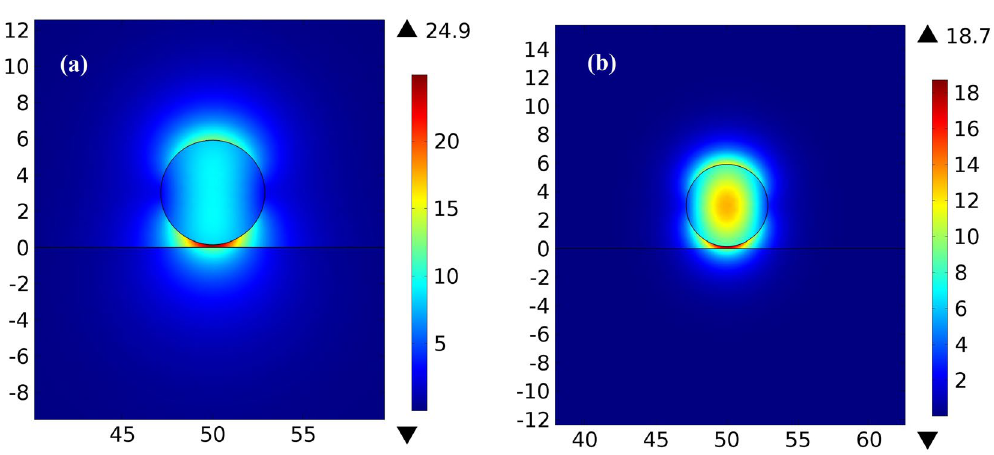
Figure 3. Simulated electric field [V/m] for ( a ) semi-insulating InP waveguide above a glass substrate ( b ) Si waveguide above a glass substrate at λ 0 = 20 µ m. Spatial dimensions are in µ